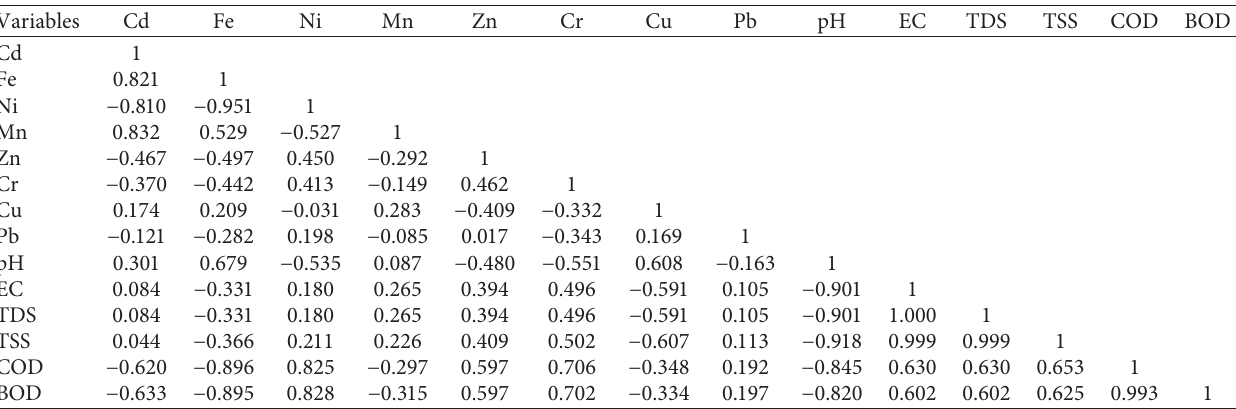
Table 3: Pearson correlation coefficient matrix ( r ) to determine the interaction levels of metal and physicochemical properties of the analyzed wastewater samples ( n � 18).